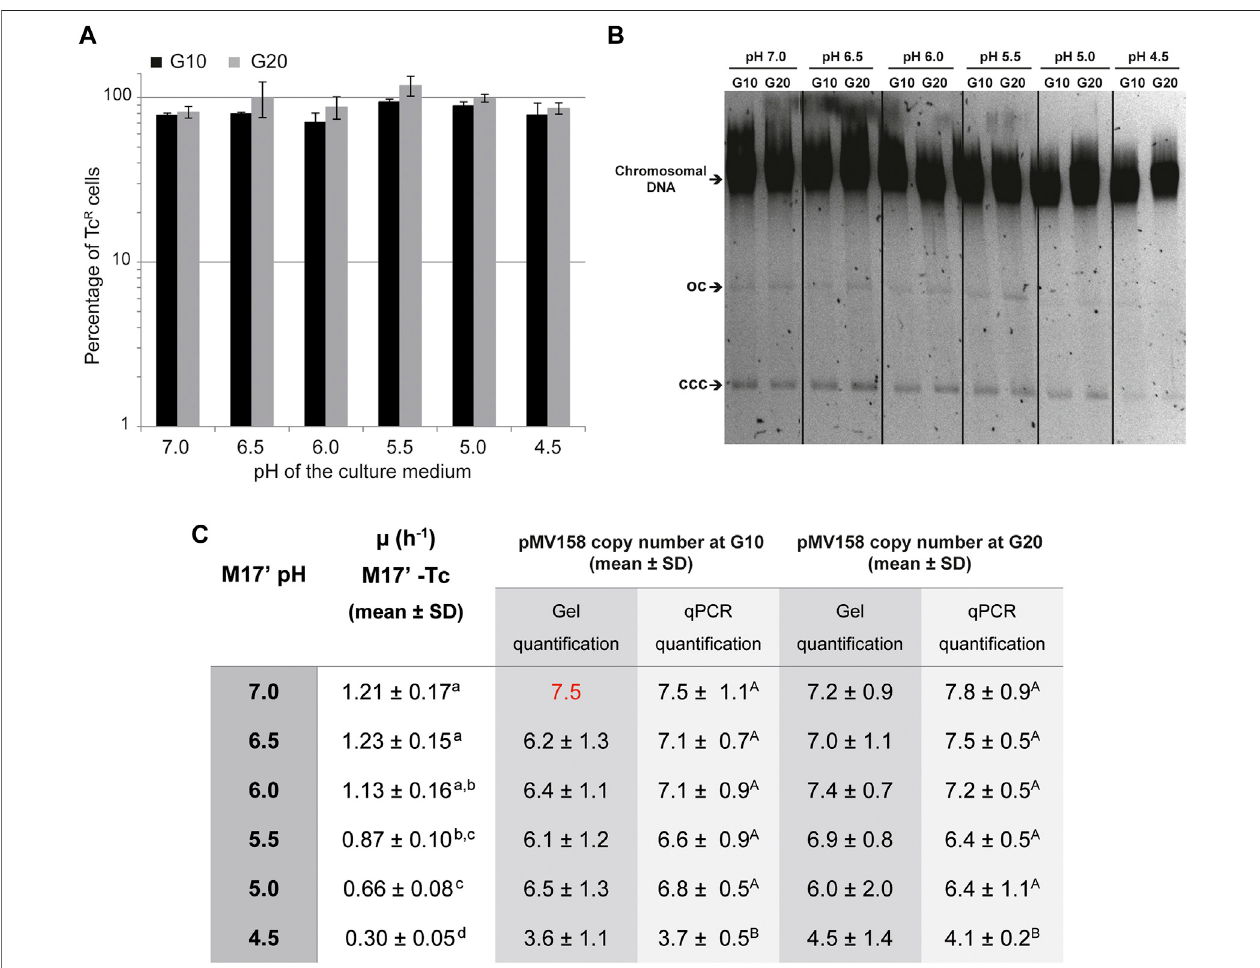
FIGURE 5 | Segregational stability and PCN of pMV158 in L. lactis grown in M17 ′ adjusted to different pHs. (A) Analysis of the segregational stability of plasmid pMV158 in L. lactis MG1363. The stability of inheritance of pMV158 was analyzed after growing the lactoccocal cells for 10 and 20 generations in M17 ′ adjusted to differentpHvaluesintheabsenceofselectivepressure.Thevertical barsrepresentanestimationofthepercentage ofTcresistant (Tc R ) cellsafter10(black bars)and20 (gray bars) generations at the indicated pHs. Bar height represents the average value of three different analysis and error bars are standard deviations. (B) The gel showsthetotalDNAcontentofthe L.lactis MG1363/pMV158straingrownattheindicatedpHsfor10and20generationsintheabsenceofTc.Supercoiledmonomeric (CCC) and open circle (OC) forms of pMV158 are indicated in the gel. Dividing lines indicate grouping of different parts of the same gel. This image is representative of at least three agarose gels used in the analysis and quanti fi cation of the DNA bands for PCN determination. (C) The table shows the pMV158 PCN in the lactococcal cells grownfor10and20generationsinTc-freeM17 ′ adjustedtodifferentpHs.ThepMV158PCNperchromosomeequivalentwasdeterminedbyqPCRorbydensitometric analysisofstainedagarosegels.Inthislattermethod,theplasmidictochromosomalDNAratioswerecomparedwiththeoneobtainedinthelactococcalhostcellsgrown at pH 7.0 for 10 generations, to which the corresponding qPCR-determined PCN value (red color number) was assigned. The table also includes the growth rates of L. lactis /pMV158inTc-freeM17 ′ mediaadjustedtothedifferentpHvalues.Thecopynumberandgrowthratevaluesgiveninthetableareexpressedasmean ± SDofthree independent experiments (biological samples). All the values with the same superscript letter were not found to have statistically signi fi cant differences. The statistical analysis of the PCN was only performed for the results obtained by qPCR, for which a lower standard deviation was